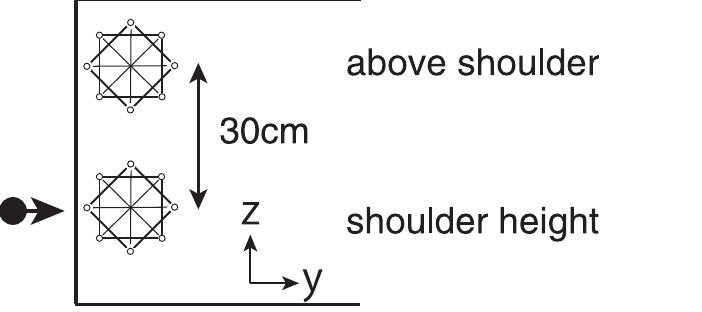
Fig 7. Experimental setup of experiment 2. The black dot depicts the position of the shoulder and the arrow shows the direction the participant is looking. The layouts were presented on a whiteboard positioned on the mid-sagittal plane of the participant. Participants wore eye masks throughout the